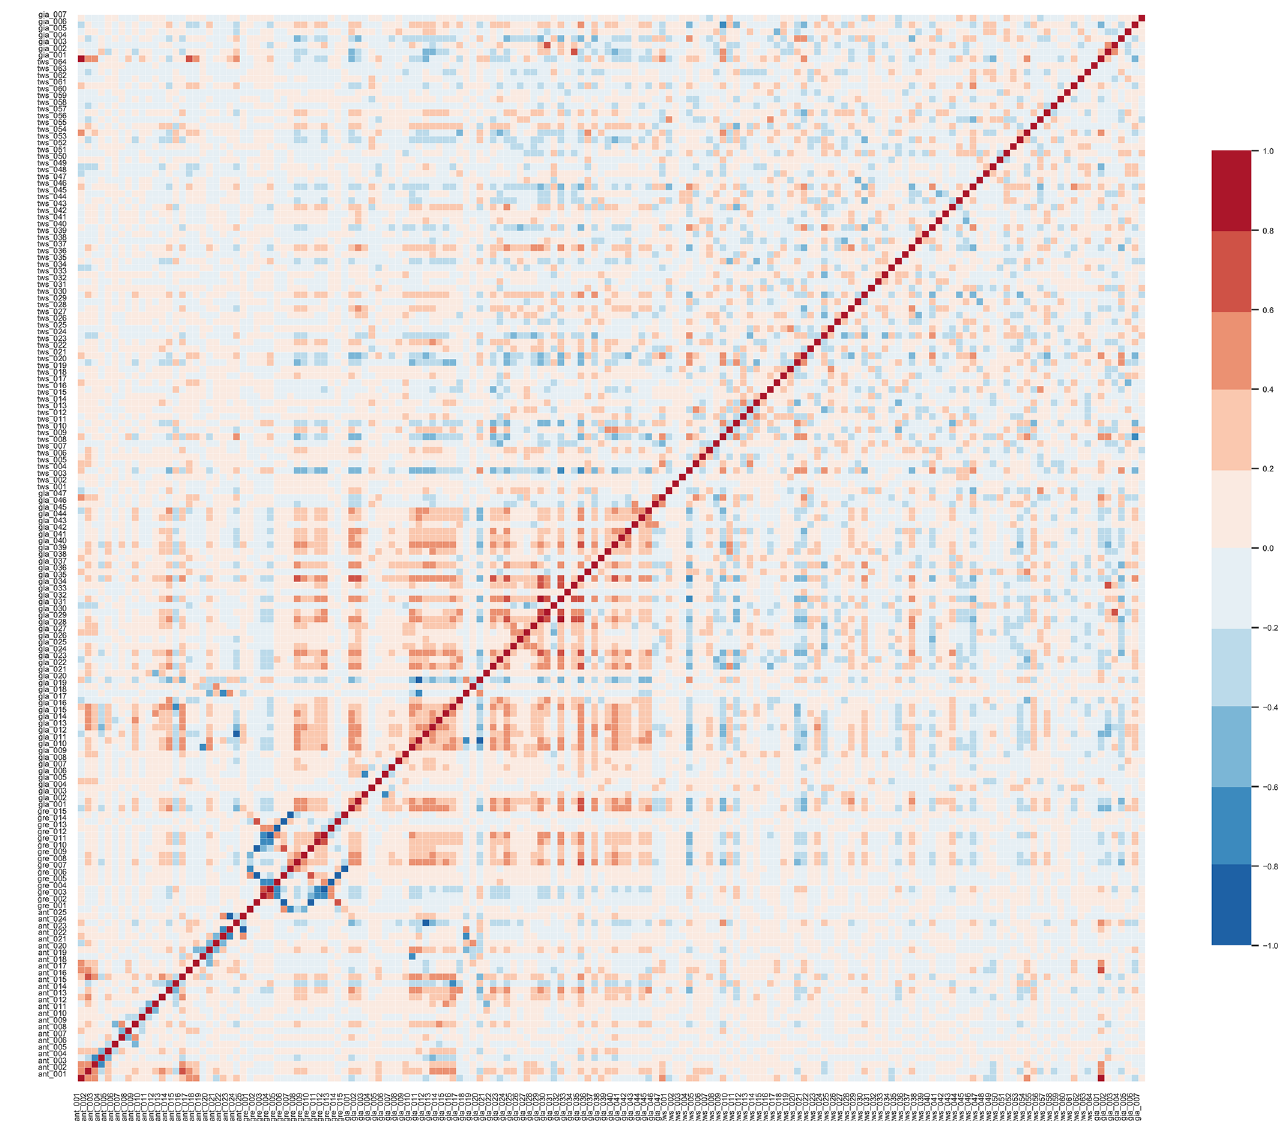
Figure 4. Correlation matrix of the 158 fingerprints used in this study. The GIA fingerprints show Antarctica (001), northern Europe (002– 003), North America (004–006), and the secular pole tide contribution (007). The location of the sources of the individual fingerprints for ice sheets and glaciers can be found in the online supplement of Sun et al.